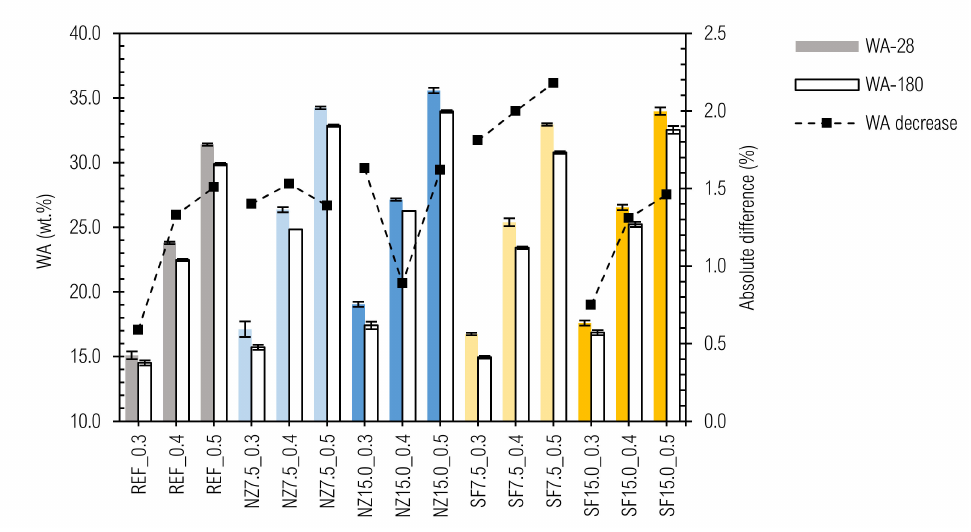
Figure 15. Results of water